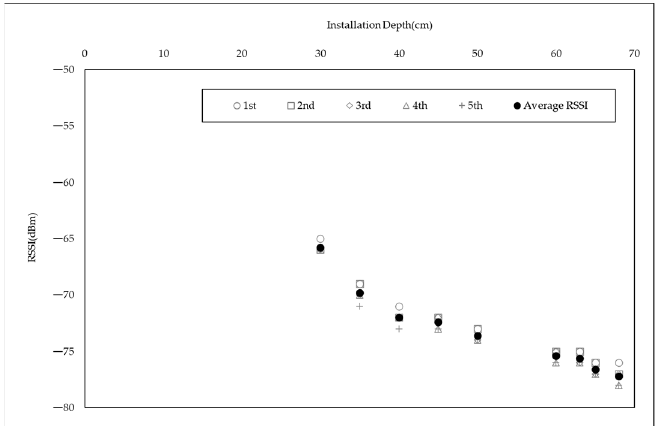
Figure 3. Experimental results of the maximum depth of signal.